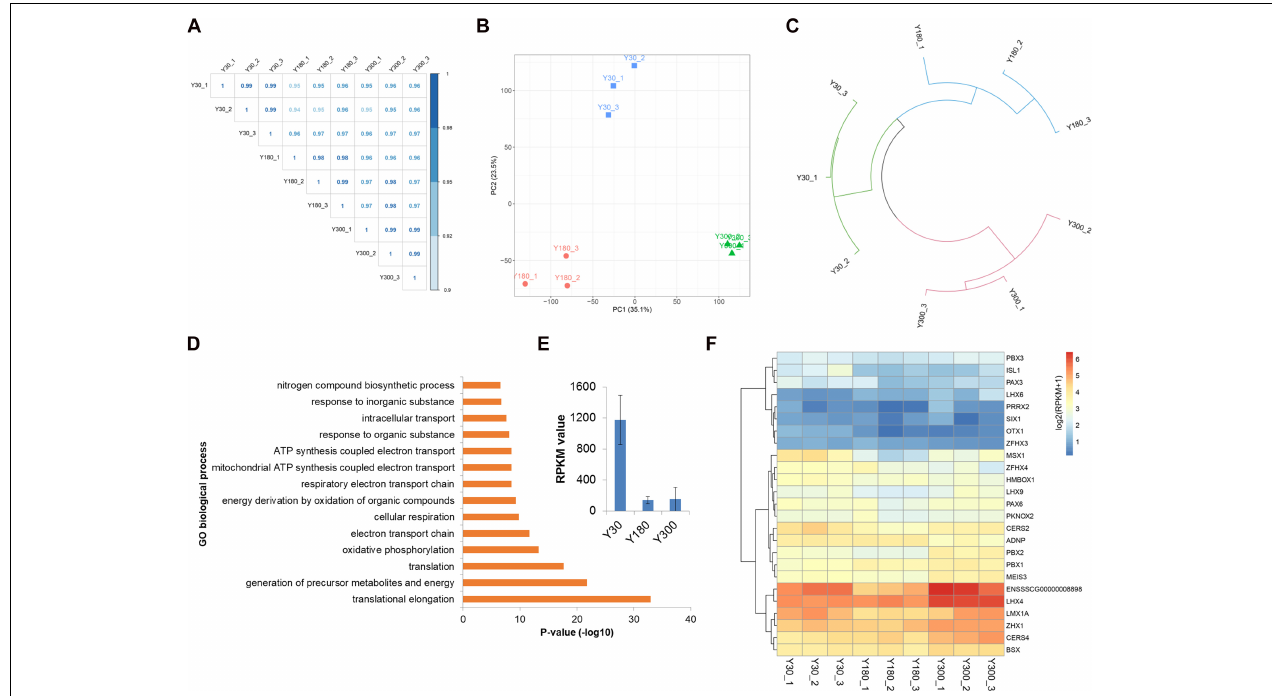
FIGURE 3 | Dynamic expression profiles of mRNAs and lncRNAs during porcine postnatal pineal development. (A) Pearson correlation plot for the pineal transcriptome of Y30, Y180, and Y300, with three replicates for each developmental stage. (B) Principal component analysis of the pineal samples across three postnatal developmental stages based on both mRNA and lncRNA expression levels. Stages are illustrated by different shapes and colors. The x - and y -axes represent the first and second PC, respectively, with the percent variance explained by each PC in parentheses. (C) Hierarchical clustering analysis of the nine pineal samples across three developmental stages based on both mRNA and lncRNA expression levels. (D) Top enriched GO biological process terms of the highly expressed genes in the pineal gland. (E) The expression of TTR gene in postnatal pineal gland. (F) Heatmap showing the expression of homeobox transcription factors during postnatal pineal